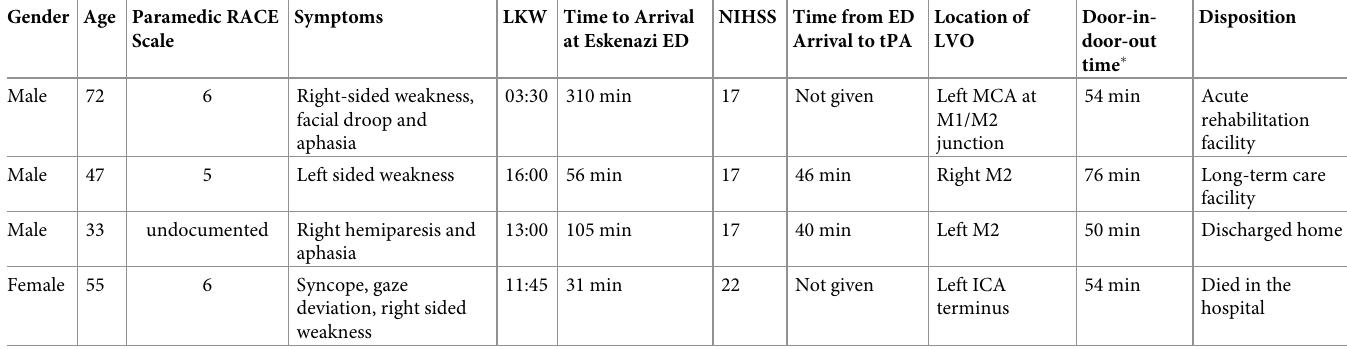
Table 3. Characteristics of patients transferred using the